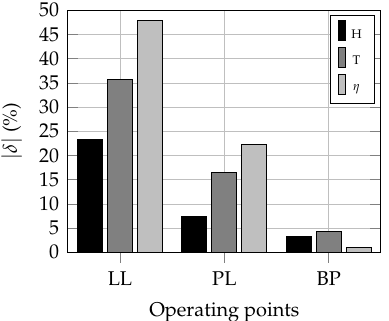
Figure 22. Relative deviations of the global CFD values Head—H (m), Torque—T (Nm) and Efficiency— η (%) at the turbine.